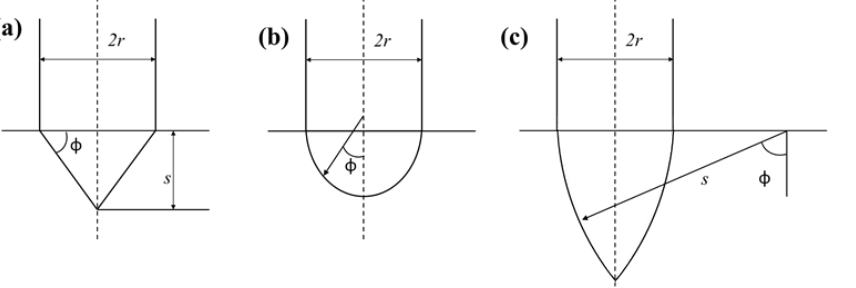
Figure 11. The projectile geometries with various nose shapes. ( a ) conical; ( b ) hemispherical; ( c ) ogival.